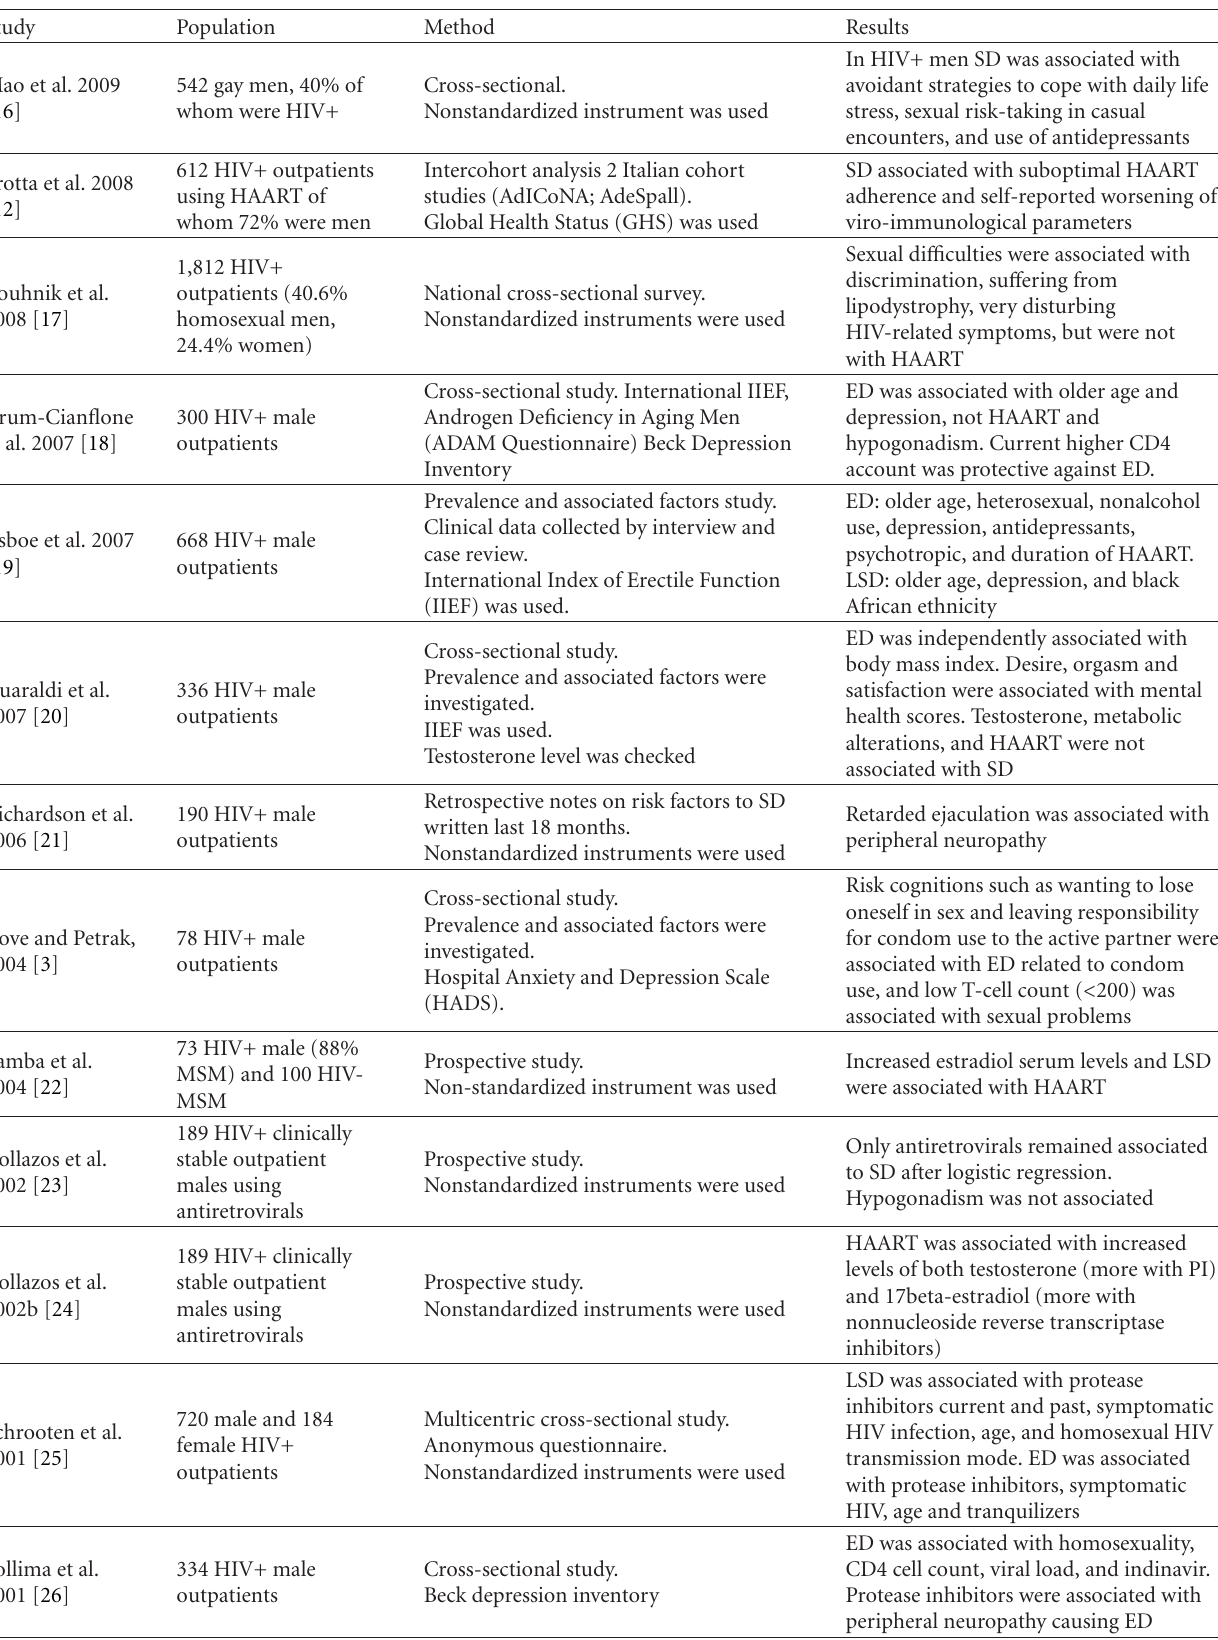
Table 1: Associated factors